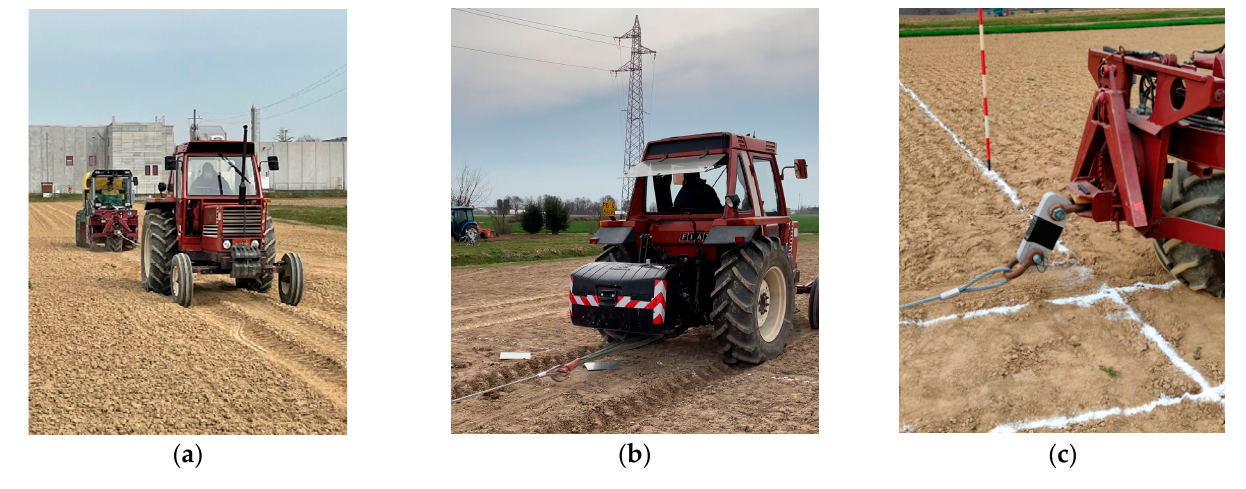
Figure 2. Two tractors used in the field experiment ( a ), counterweight attached in the back of the front tractor ( b ) and dynamometer between the tractors ( c ).